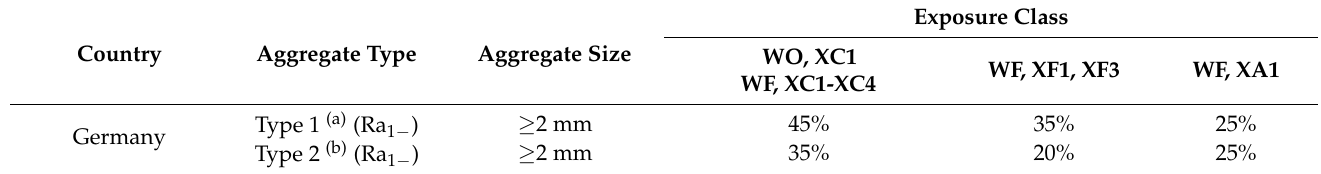
Table 6. Percentage of substitution of natural aggregate by bituminous aggregates in Germany.